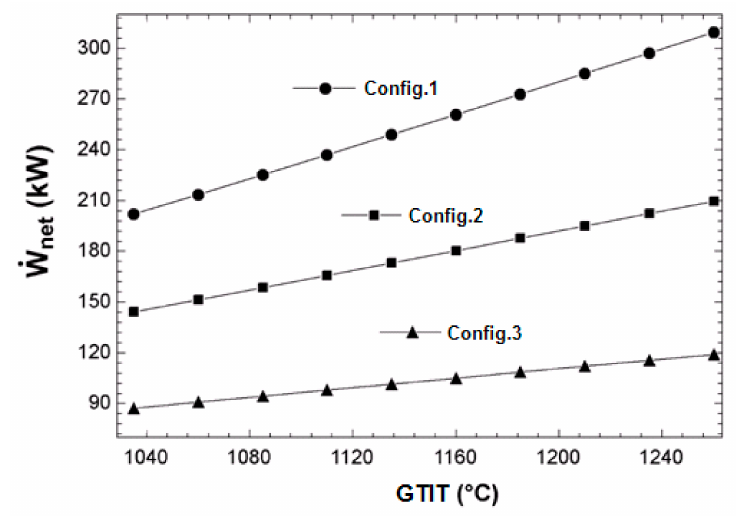
Figure 9. Effect of gas turbine inlet temperature change on the overall output power.